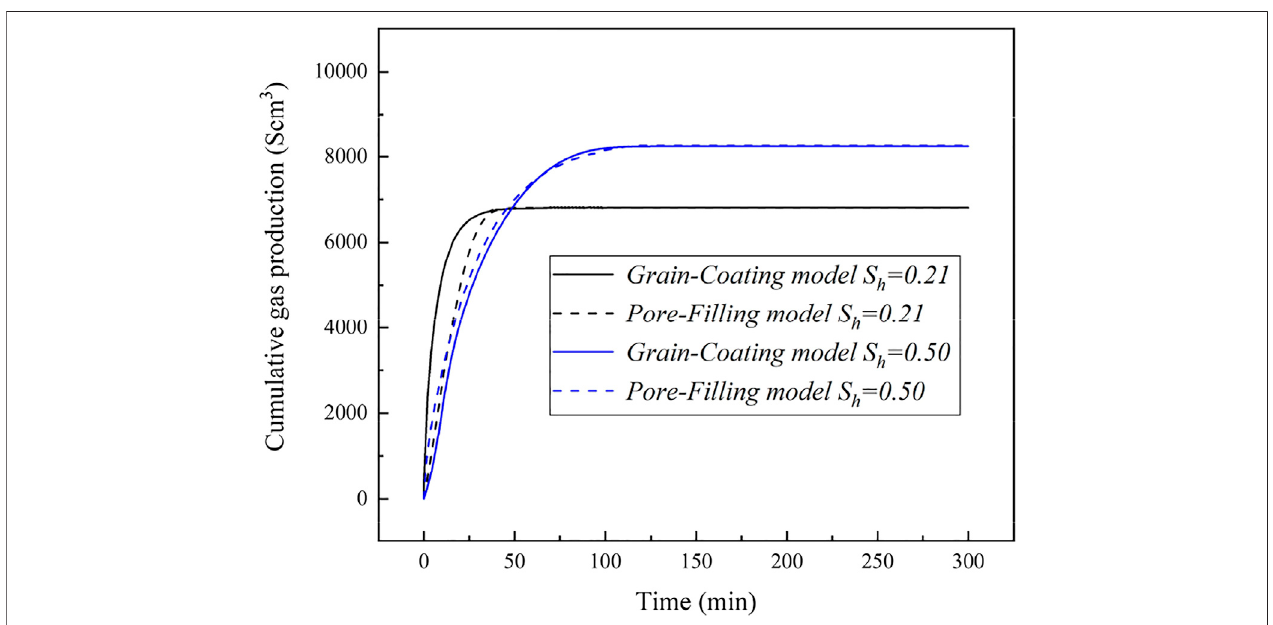
FIGURE 12 | Cumulative gas production time evolution for different hydrate dissociation surface area at the hydrate saturations of 21% and 50%.